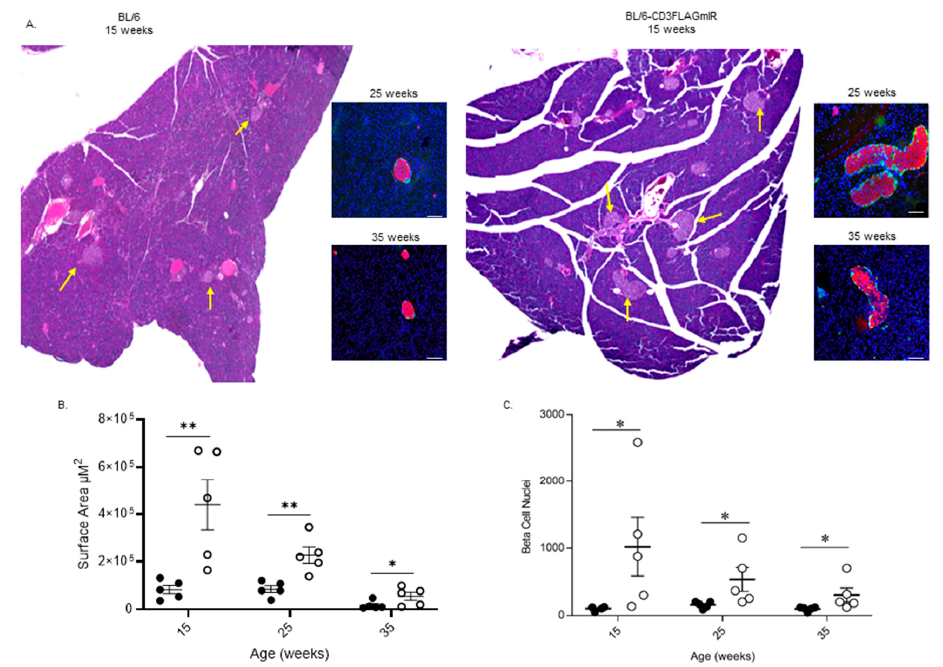
Figure 6. Tunnel staining and analysis. A. Immunohistochemistry labeling of pancreatic tissue sections from 15-week-old mice representing TUNEL + apoptosis in the islet of the transgenic mice. Scale bar 50 µm. B. Quantitative analysis of total number of TUNEL-positive cells per islet based on immunohistochemistry TUNEL labelling of 15 ( n = 3), and 25 week ( n = 3) old mice pancreatic tissues. -/- indicates BL/6 mice and +/+ indicates BL/6-CD3FLAGmIR mice. ( n = 23 islets assessed per mouse). One Way ANOVA: * p ≤ 0.05.